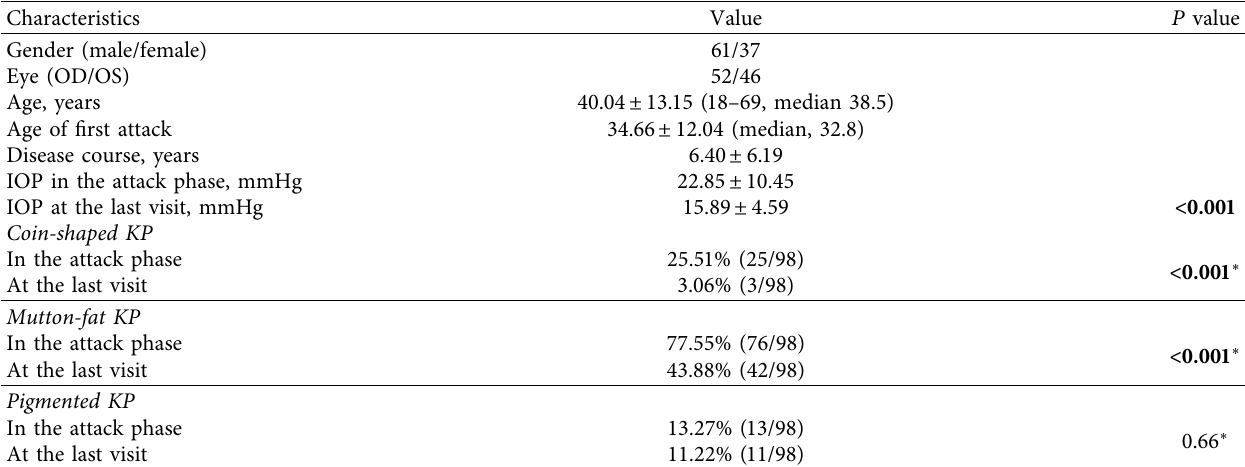
Table 1: Baseline characteristics of the 98 patients with Posner–Schlossman syndrome.